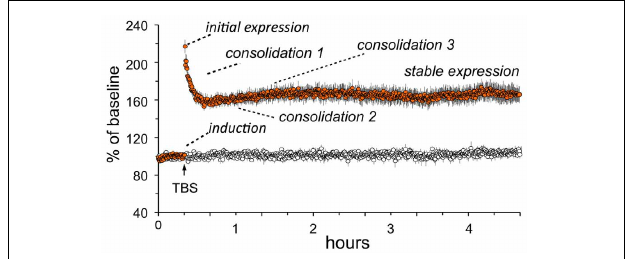
FIGURE 2 | Characteristics of long-term potentiation (LTP). Stimulation was applied to two populations of Schaffer-commissural afferents converging on the stratum radiatum of field CA1b. Theta burst stimulation (TBS) delivered to one input (filled circles) causes an immediate increase in the size of the field EPSP which then decays over about 10min to a plateau at which the responses are 50–60% elevated above the pre-TBS baseline. The potentiation persists unchanged for the duration of the recording session (nearly 5h in the illustrated case). Note that the second (control) input, which received only 3/min stimulation pulses, was not affected by potentiation of neighboring contacts (open circles). Thus, LTP has the synapse specificity expected for a memory substrate. As with memory encoding, LTP is initially unstable and readily erased by a number of treatments (e.g., 5Hz stimulation) but then becomes steadily more resistant to disruption. Experimental work indicates that this process involves multiple stages. A rapid phase (“consolidation 1”) has been linked to reorganization of the sub-synaptic cytoskeleton over the 10min following TBS; this is followed at about 1h by a newly discovered stabilization event (“consolidation 2”) involving synaptic adhesion receptors. There is also considerable evidence for a still later step that depends on protein synthesis (“consolidation